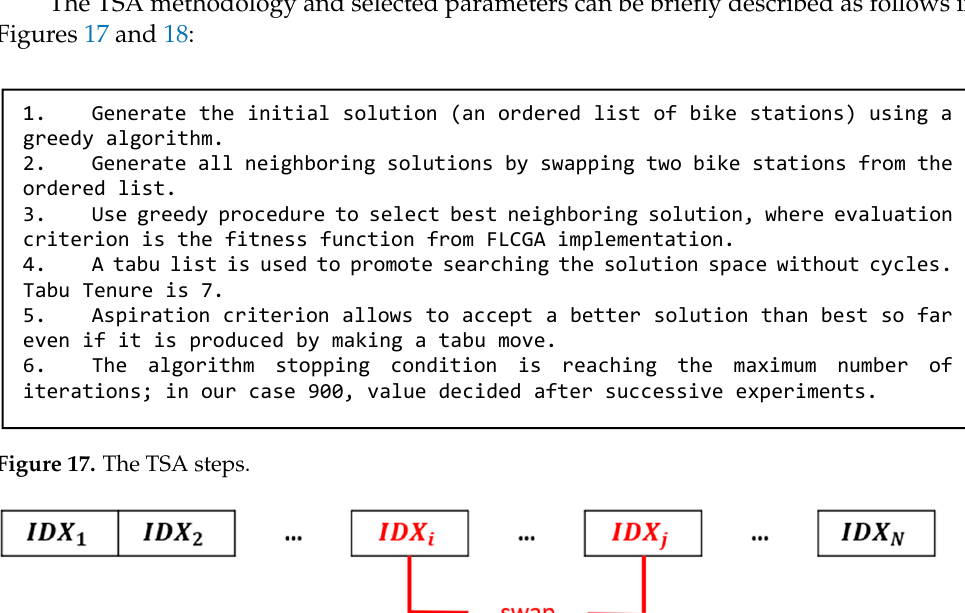
Table 8. ( a ) Performance of the FLCGA for di ff erent numbers of bike stations to rebalance. ( b ) Per-